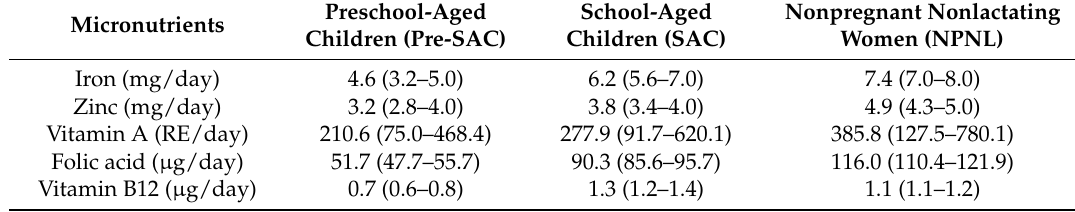
Table 2. Mean (95% confidence interval, CI) micronutrient intake by population group per capita.